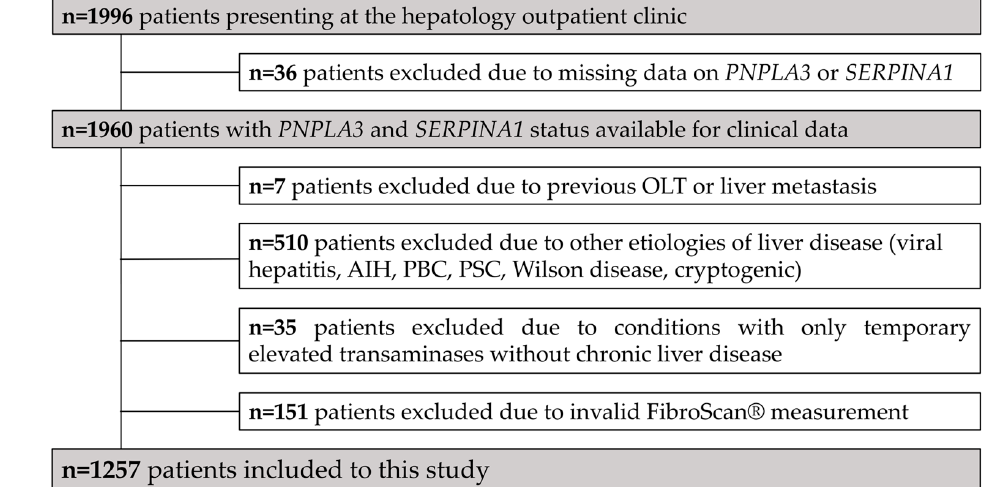
Figure 1. Study flow chart. From the 1996 eligible patients, 739 patients were excluded, and 1257 patients were included in this study. AIH—autoimmune hepatitis; OLT—orthotopic liver trans- plantation; PBC—primary biliary cirrhosis; PSC—primary sclerosing cholangitis.